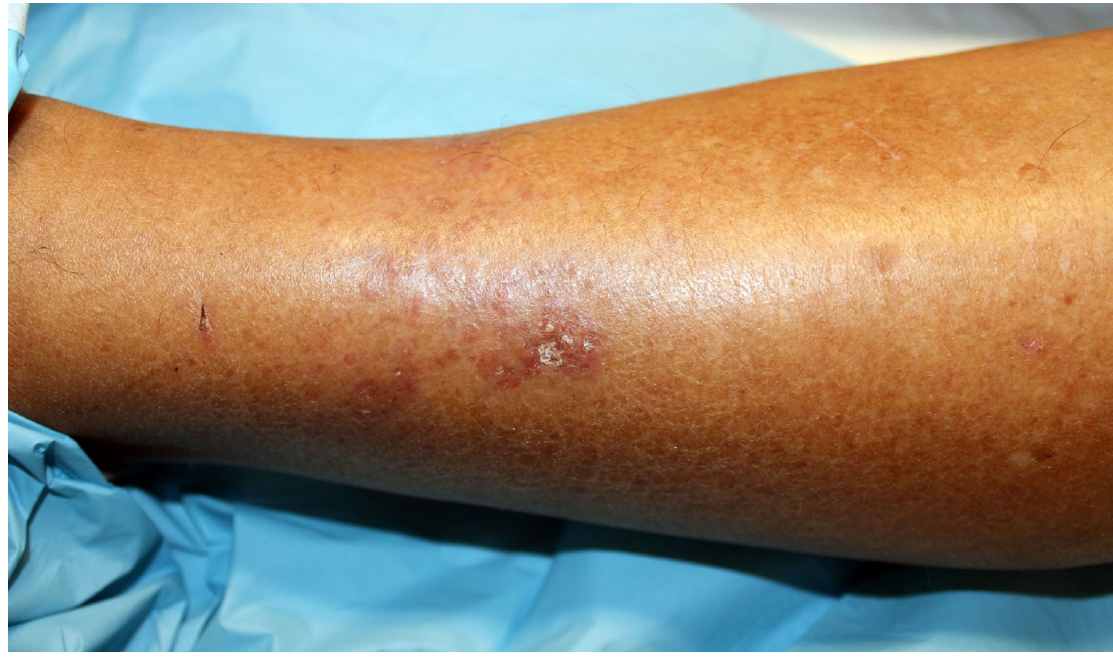
Figure 1. Erythematous plaque centered by erosion covered by crust on left